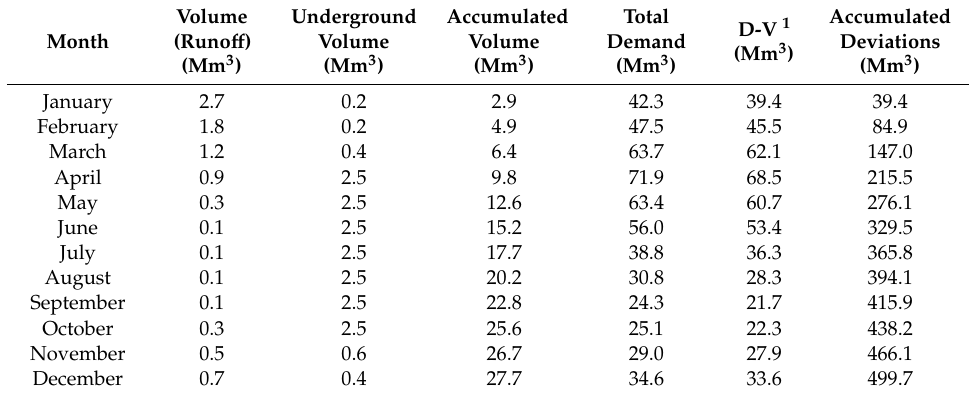
Table 7. Average Multi-annual Monthly Volume (runoff + underground) vs. Demand for Guadalupe